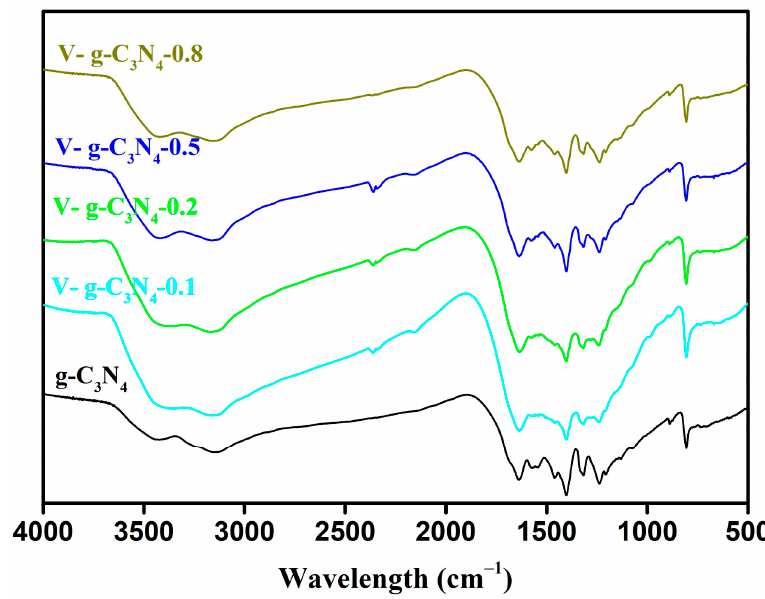
Figure 3. FT ‐ IR spectra of the materials.